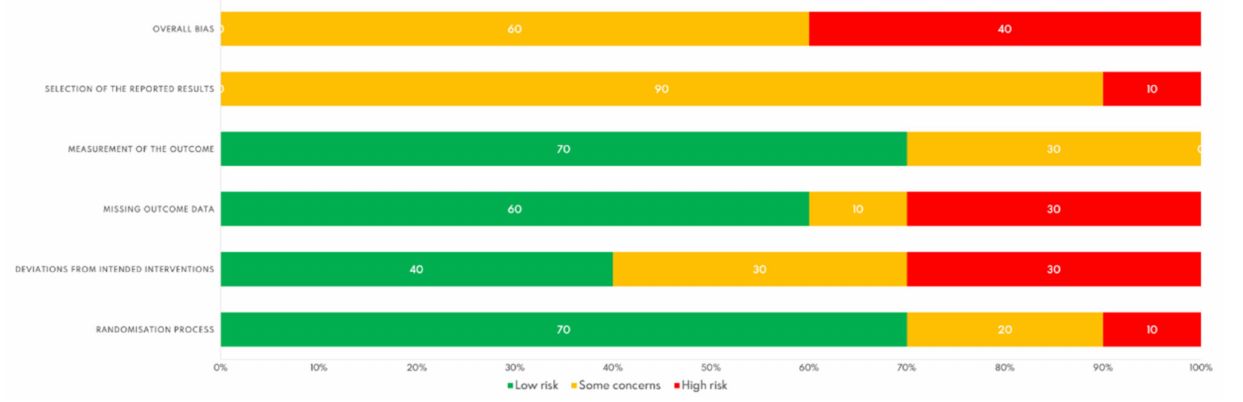
Figure 2. Risk of bias